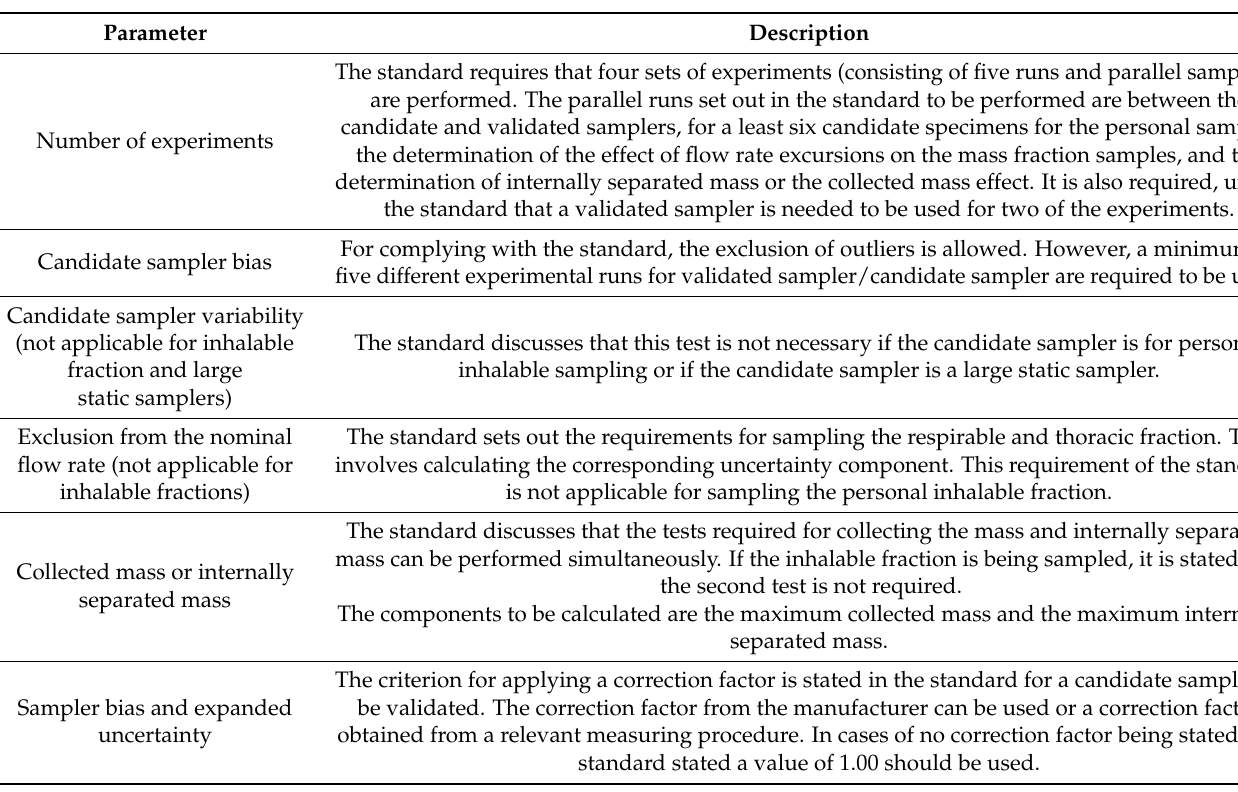
Table 1. Selected Experimental Requirements for EN13025:5 for workplace sampler performance